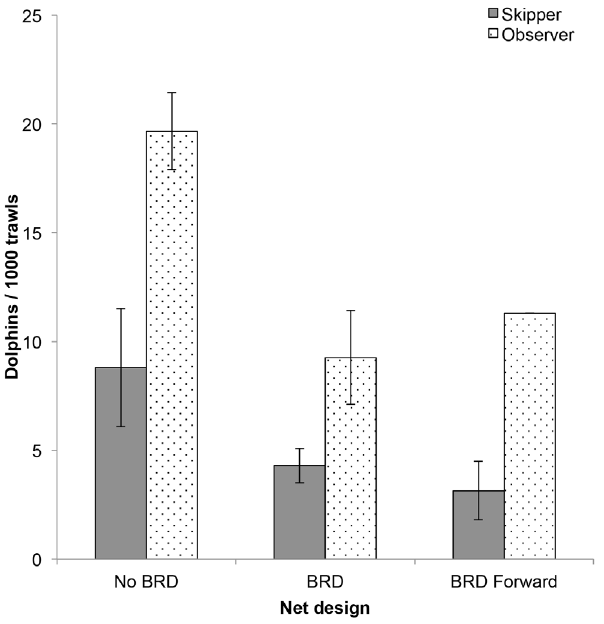
Figure 4. Dolphin bycatch rates by differing net design in the Pilbara Trawl Fishery. Mean ( 6 1 SE) dolphin bycatch rates by differing net designs. BRD=BRD fitted just forward of the codend and at the aft end of the tubular net extension; BRD forward=BRD moved to the forward end of the extension.